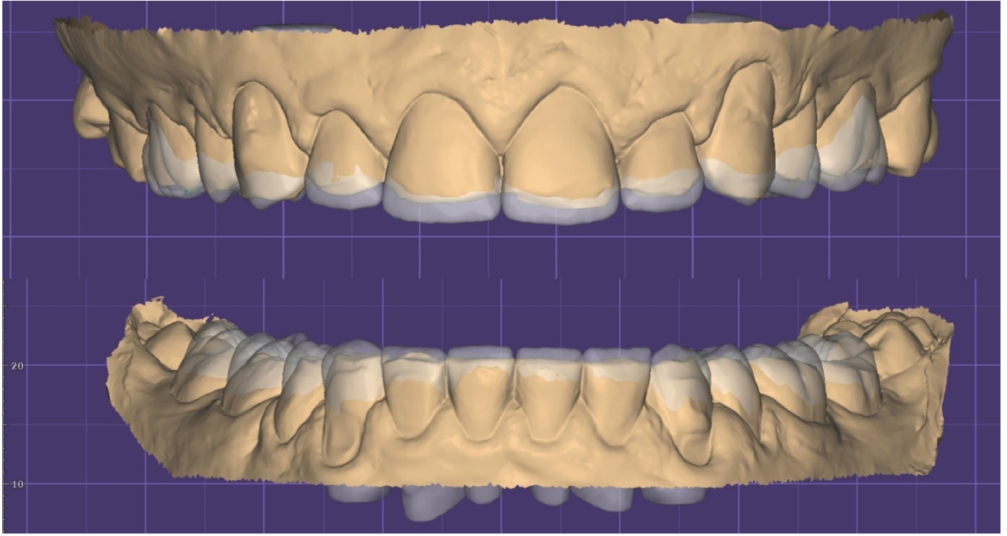
Figure 11. STL Digital wax up